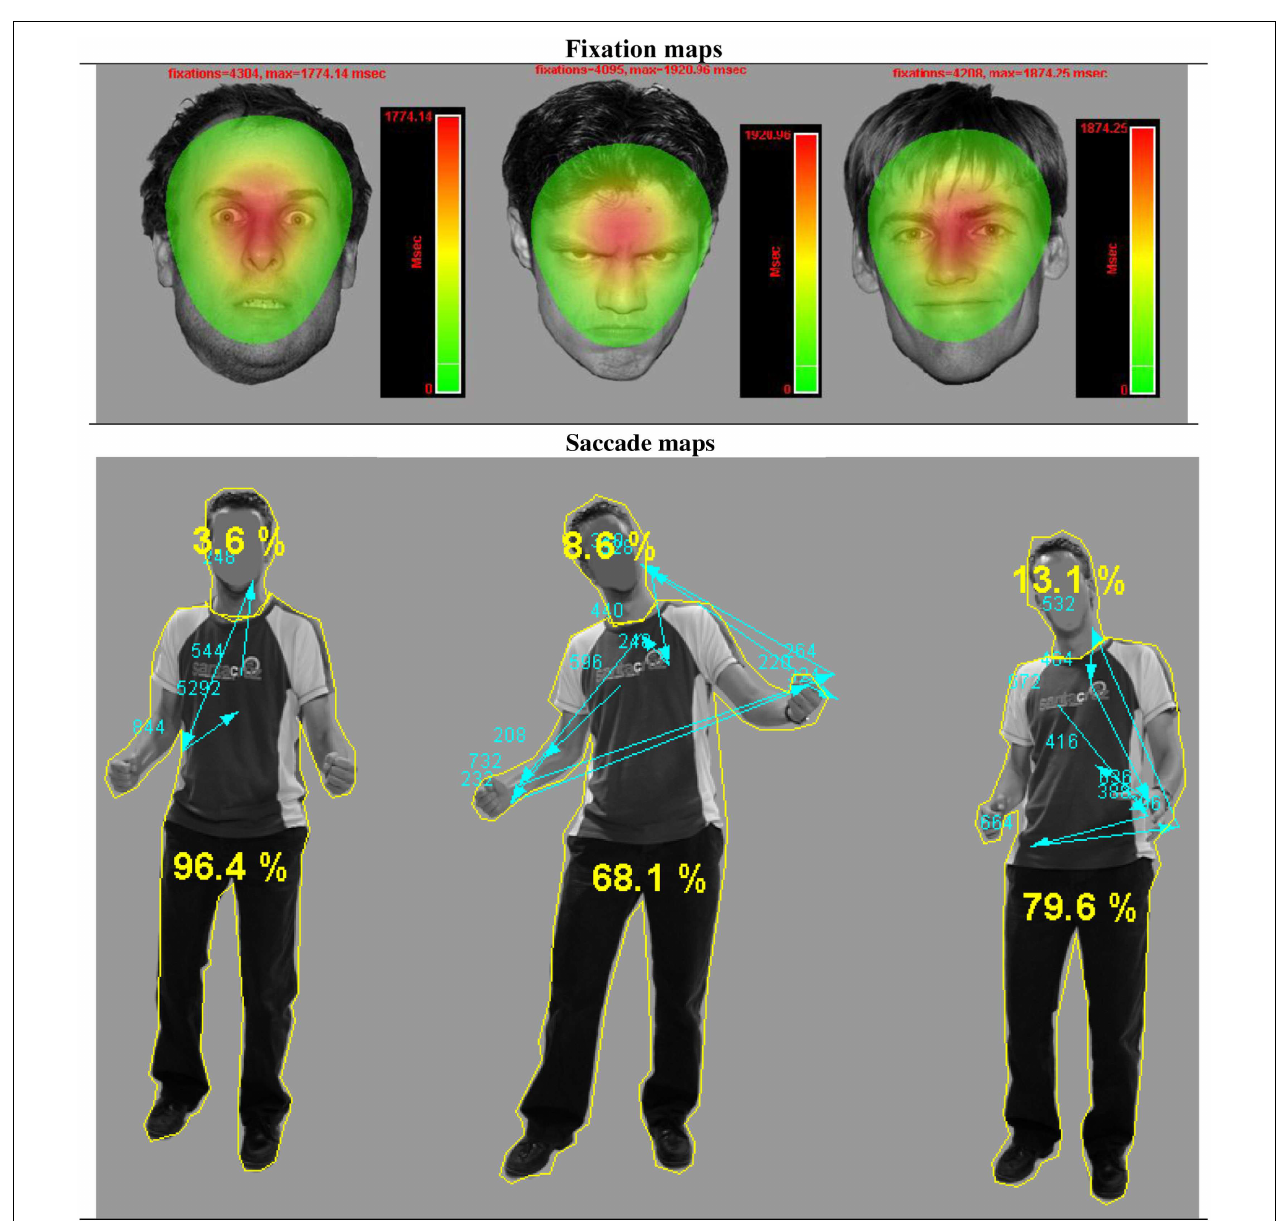
eye region.The picture with the body postures shows the distribution of fixations and saccades of one participant on three different trials.The yellow lines around the head and body are the interest areas and the yellow numbers, the percentage of the total fixation duration that fell in either the face or the body ROI.The blue arrows indicate the saccades, starting from the chest (fixation cross) and the blue numbers the fixation